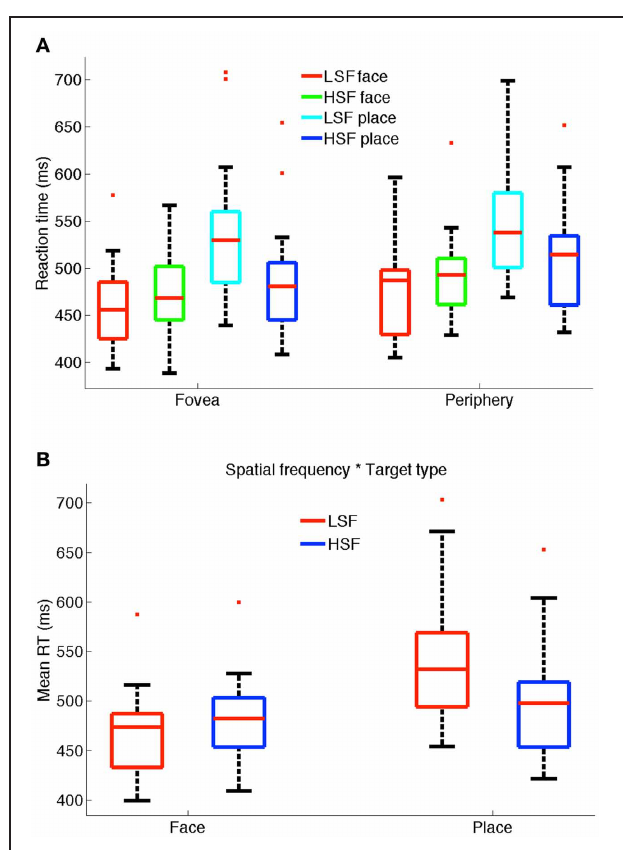
FIGURE 2 | (A) Reaction time distribution for faces and places in LSF and HSF conditions for fovea and periphery. The bottom and top of the box show the 25th and 75th percentiles respectively. The whiskers extend to the most extreme value that is less than or equal to 1.5 times the box height. Outliers (values outside the whiskers) are shown by red plus signs. (B) Box-plot shows significant two-way interaction between spatial frequency and target